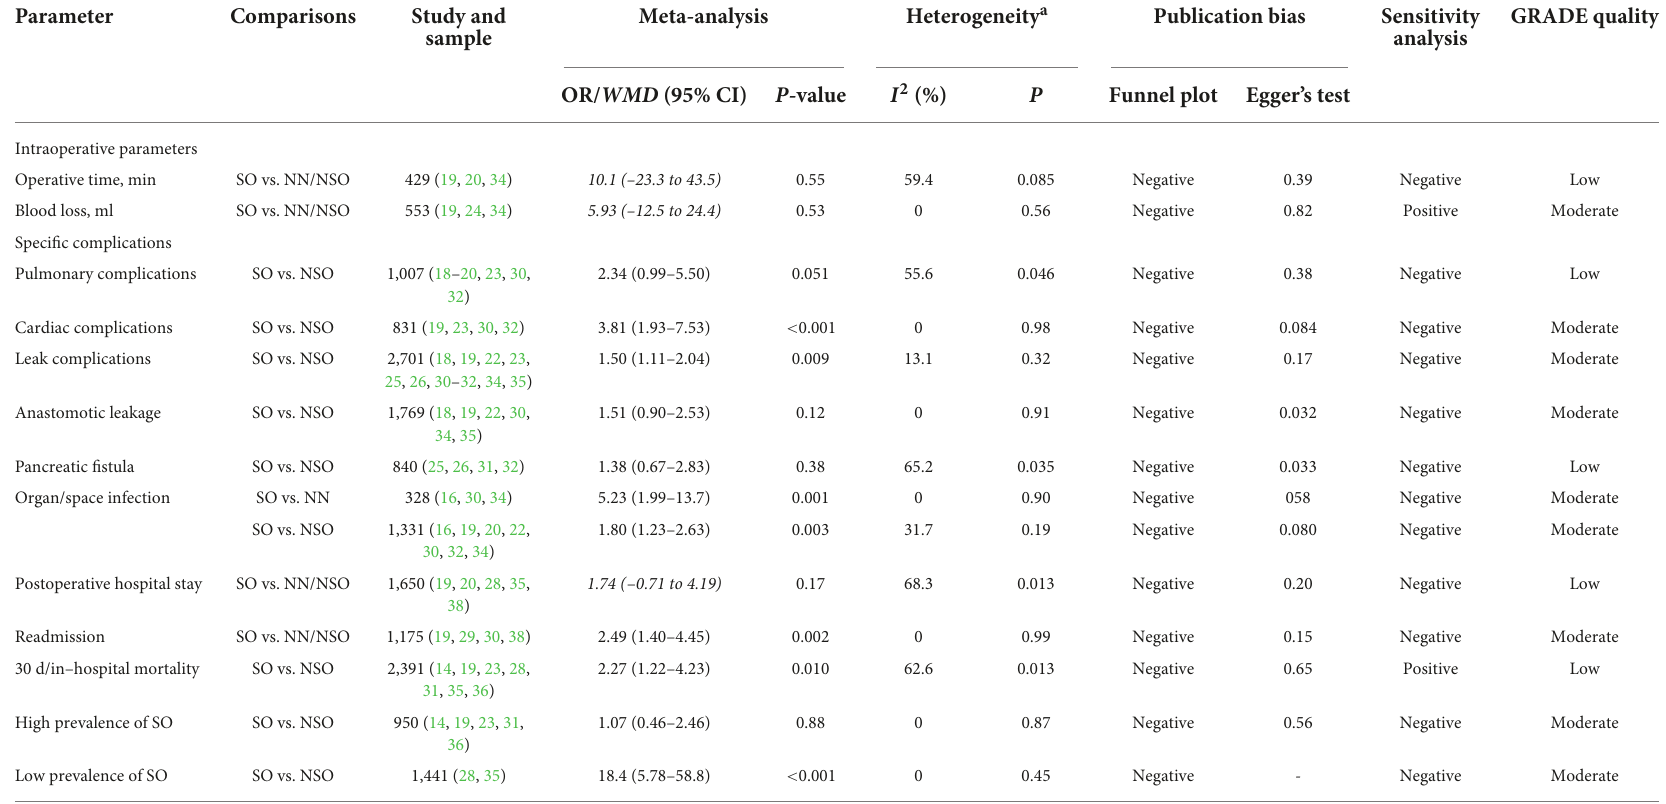
TABLE 4 Meta-analyses of second endpoints in sarcopenia obesity